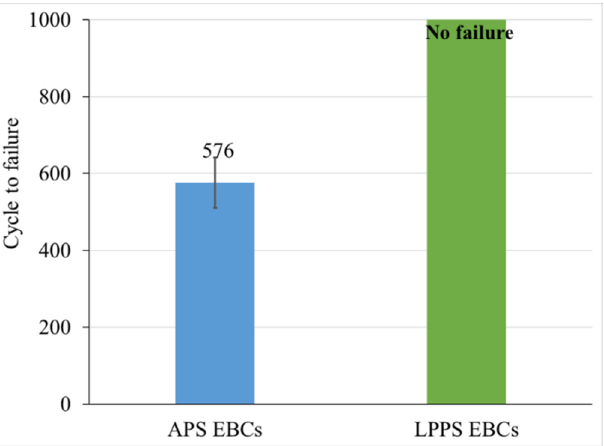
Figure 5. Thermal cycling life of APS and LPPS EBCs in steam environment at 1316 °C. APS EBCs have an average life of 576 ± 65 cycles, while LPPS EBCs survived 1000 cycles without failure.